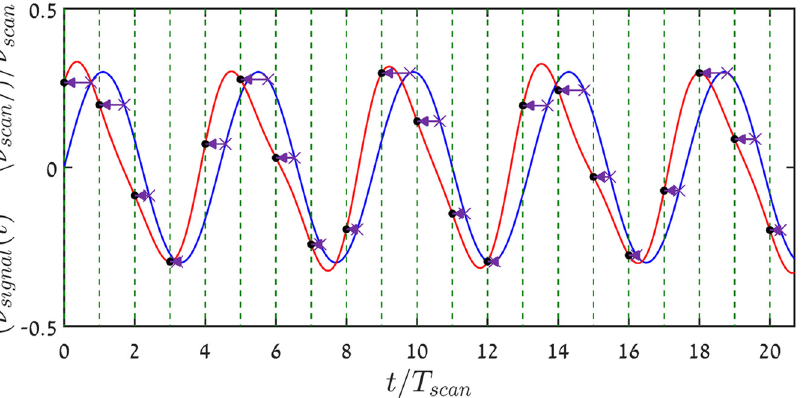
Figure 2. The original sinusoidal signal (blue) of Figure 1, together with its Nyquist–Shannon sinc-reconstruction (red) from the sampled values, { s n } N − 1 , assuming the latter are attributed (see horizontal arrows) to the scans’ starting points (vertical dashed green lines). Shown are the middle ~20 scan periods out of 1100, starting at − 550 T scan .